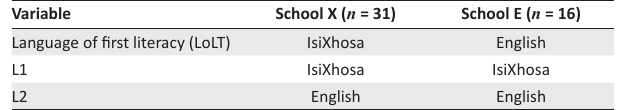
TABLE 1: Languages used at School X and School